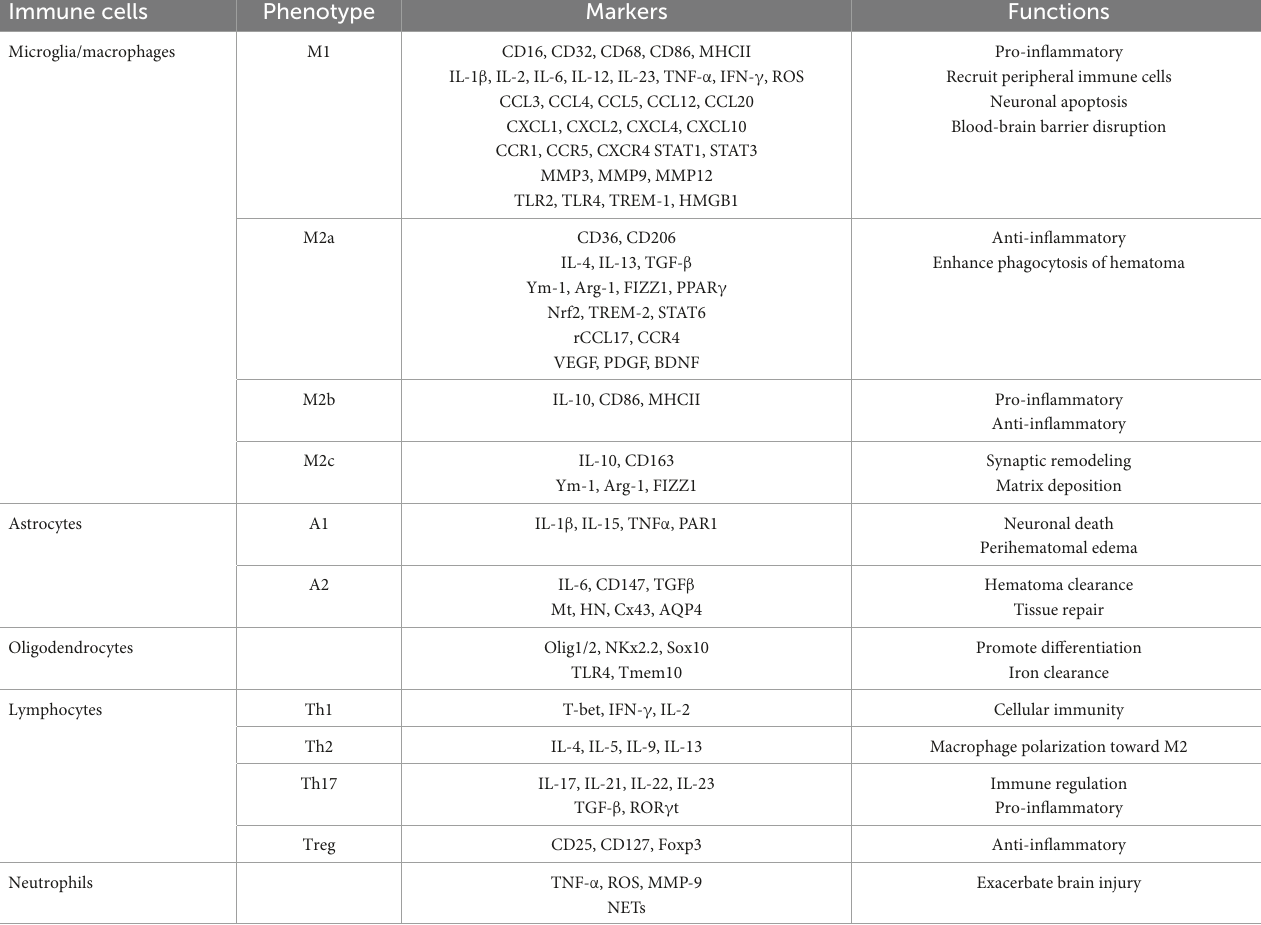
TABLE 1 Markers and functions of immune cells. Immune